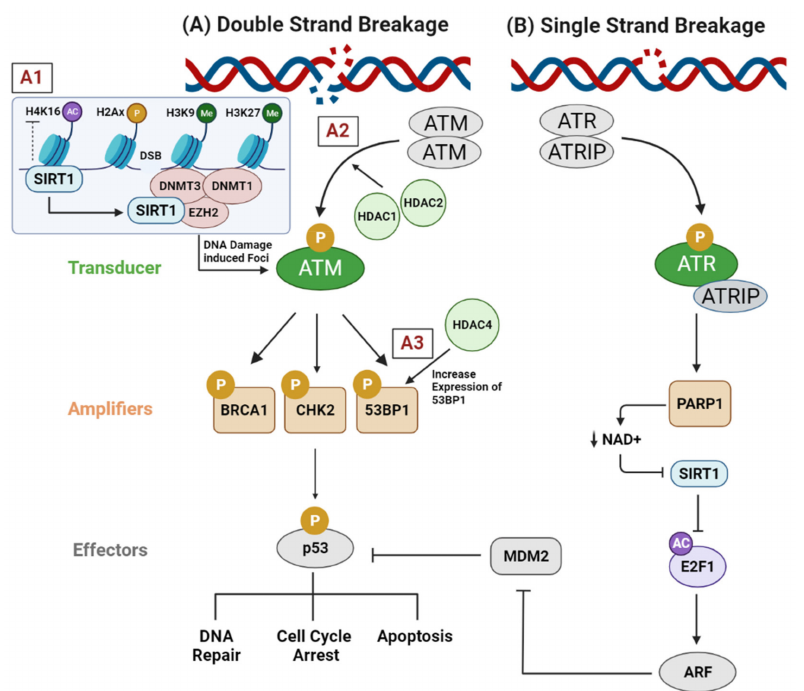
Figure 2. Role of HDACs in the modulation of DNA repair machinery. ( A ) After DNA double strand breakage, (A1) SIRT1 is directed towards the DNA damage site to induce chromatin reorgani- zation by recruiting epigenetic machinery including DNMT1, DNMT3B, and EZH2. These epigenetic modifiers induce histone repressive modifications, such as hypoacetylation of H4K16 and methylation of H3K9 and H3K27, that help to establish the compaction of chromatin around the damaged site. (A2) HDAC1 and HDAC2 contribute to ATM activation in several tumor types, thereby enhancing the subsequent phosphorylation of BRCA1, CHK2, and p53, which decreases the susceptibility of DNA breakage. (A3) HDAC4 increases the expression of the tumor suppressor gene 53BP1, a protein involved in the early stages of DNA damage signaling. This signaling cascade facilitates the phospho- rylation and activation of p53 protein, which promotes cell cycle arrest to allow DNA repair and/or apoptosis. ( B ) Upon induction of single stand breaks, poly(ADP-ribose) synthesis is catalyzed by PARP1 at unrepaired single break sites, which reduces the activity of NAD+-dependent deacetylase SIRT1 through decreasing the cellular concentration of NAD+. Consequently, the acetylation of E2F1 is maintained, which activates the transcription of ARF, which inhibits MDM2, a negative regulator of p53. This allows p53 to exert its tumor suppressor transcriptional regulation or/and to induce apoptosis. Abbreviations: DNMT, DNA methyltransferase 1; DNMT3B, DNA methyltransferase 3B; EZH2, enhancer of zeste homolog 2; ATM, ataxia-telangiectasia mutated; BRCA1, breast can- cer gene 1; CHK2, checkpoint kinase 2; 53BP1, p53-binding protein 1; ATR, ataxia-telangiectasia and Rad3-related; ATRIP, ATR interacting protein; PARP1, poly(ADP-ribose) polymerase 1; NAD+, nicotinamide adenine dinucleotide; E2F1, E2F transcription factor 1; ARF, alternative reading frame; MDM2, mouse double minute